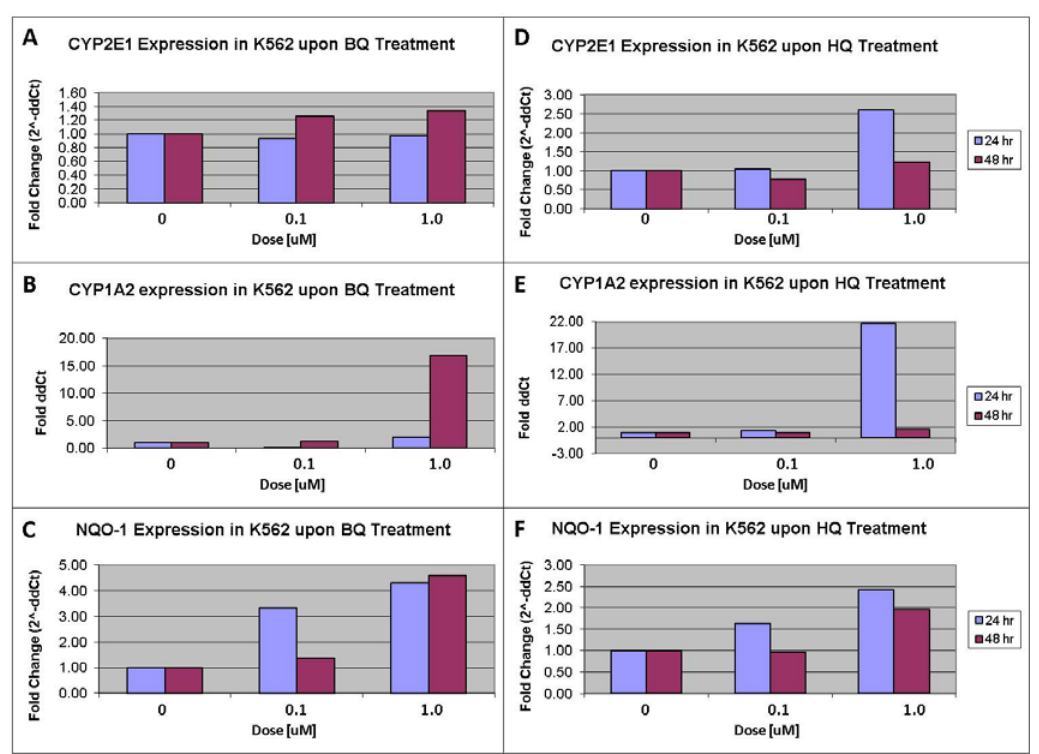
Figure 4. Representative mRNA expression levels of CYP2E1 ( A ); CYP1A2 ( B ) and NQO1 ( C ), as measured by real time reverse transcriptase-polymerase chain reaction in the K562 cell line, at 24 and 48 hours, after exposure to benzoquinone (BQ). Representative mRNA expression levels of CYP2E1 ( D ); CYP1A2 ( E ) and NQO1 ( F ) under the above conditions after exposure to HQ. Induction of CYP1A2 is marked ( B , E ); with mild induction in CYP2E1 ( A , D ) and NQO1 ( C , F